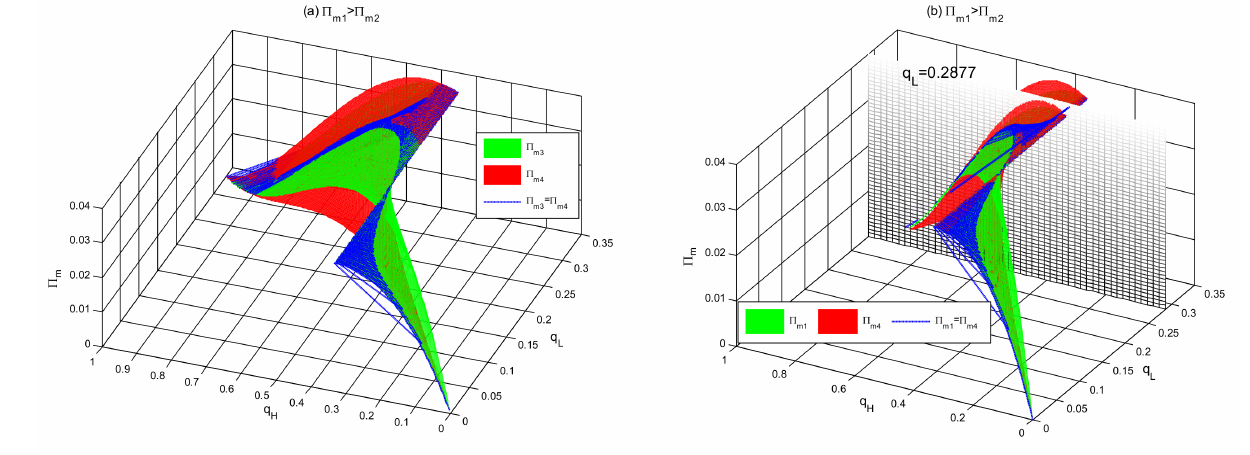
Figure 6. Π m 3 versus Π m 4 versus Π m 1 when q H (1 − q H ) 2 > q L (1 − q L ) 2 .